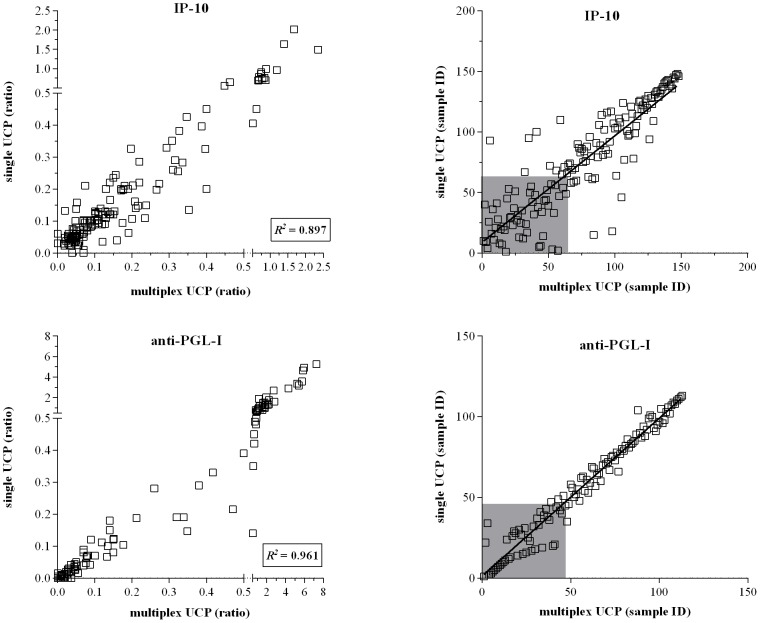
Comparison between single and multiplex UCP-LFAs.UCP-LFAs were performed for single or multiplex detection of IP-10 (upper panel; n = 149 samples) and anti-PGL-I (lower panel; n = 115 samples) using M. leprae antigen-stimulated WBA samples of Dutch and Ethiopian leprosy patients. Simultaneous detection of IP-10 and anti-PGL-I IgM was performed following the two phase protocol using the UCPαIP-10conjugate and the UCPαIgM conjugate. Left panel: Results for UCP-LFAs are displayed as the ratio of the relative fluorescence units (RFUs) measured at Test and Flow-Control lines. R2 equals the square of the Pearson correlation coefficient. Right panel: Spearman ranking. The grey box indicates samples scoring values below the specificity threshold.